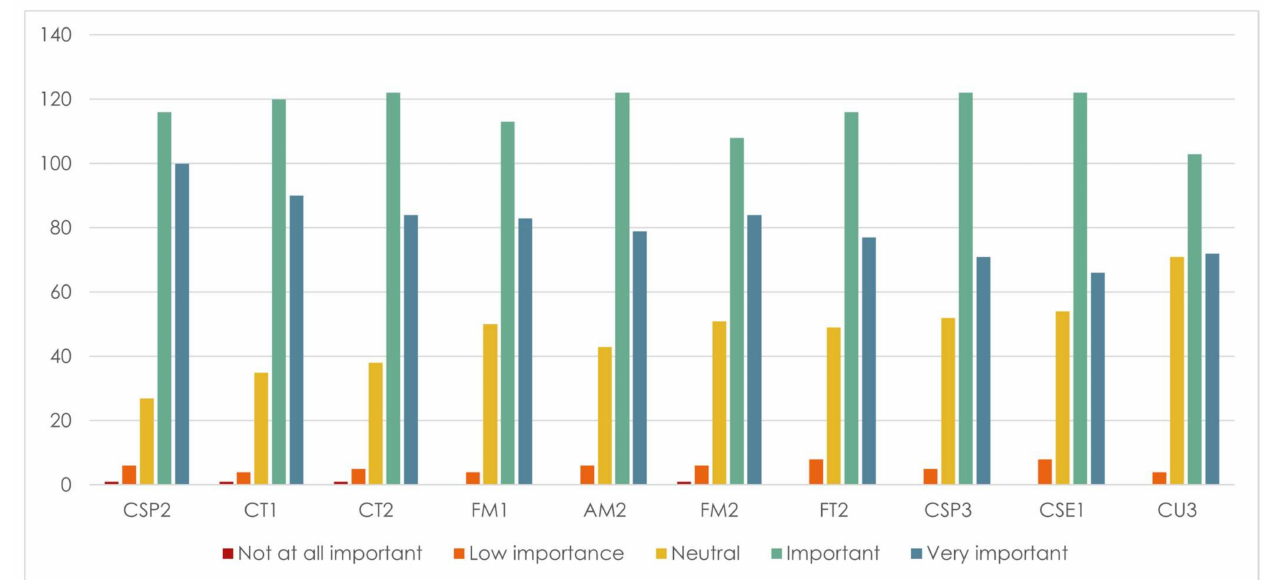
Figure 2. Perceived importance perception of service scalability and diversity